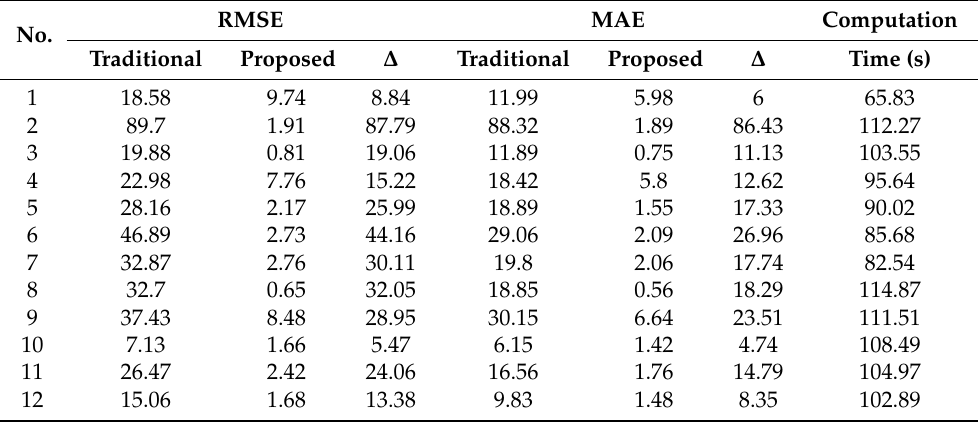
Table A3. Performance comparison for medium-term solar power forecasting (October) by the